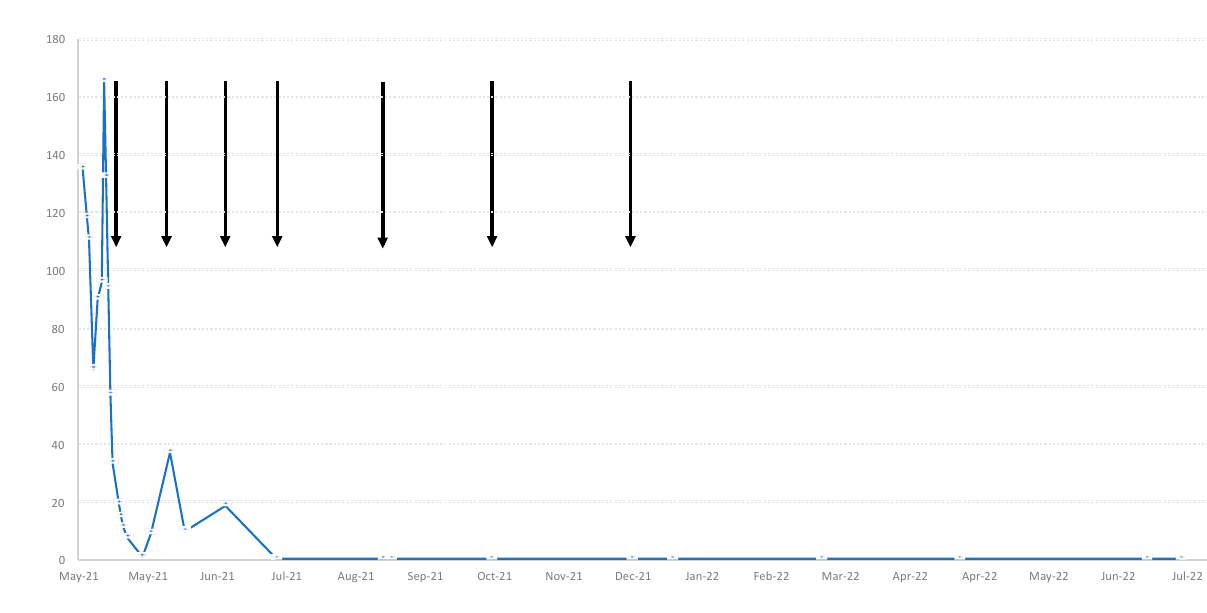
Figure 2. C-reactive protein (CRP, mg/L over time and siltuximab infusions (arrows).